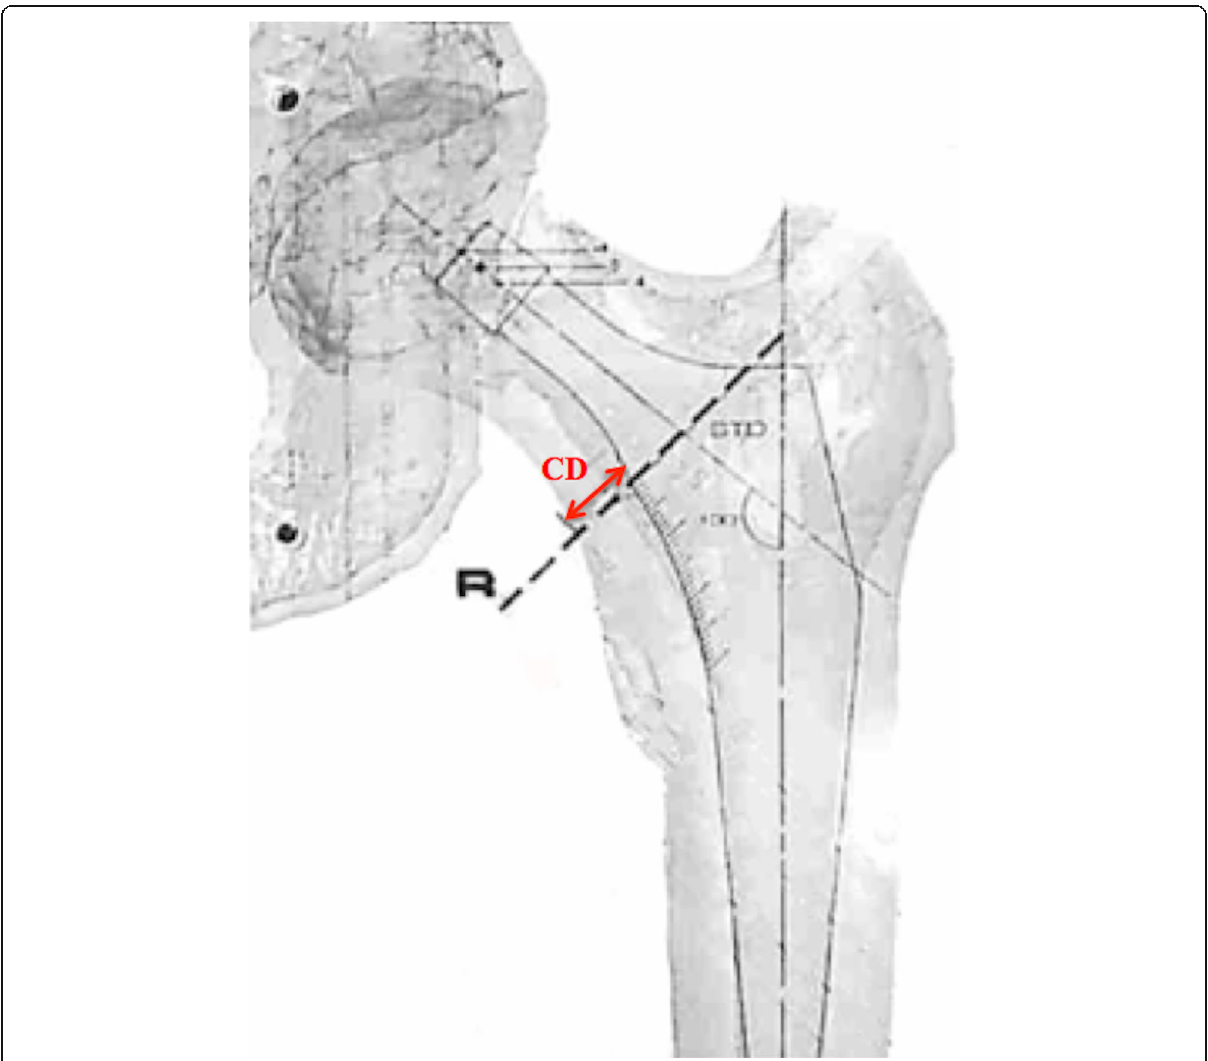
Fig. 3 Templating femoral stems on printed CT-scans to select the size and model of the stem matched and to measure the cortical distance (CD) at the level of the collar resection (femoral calcar)